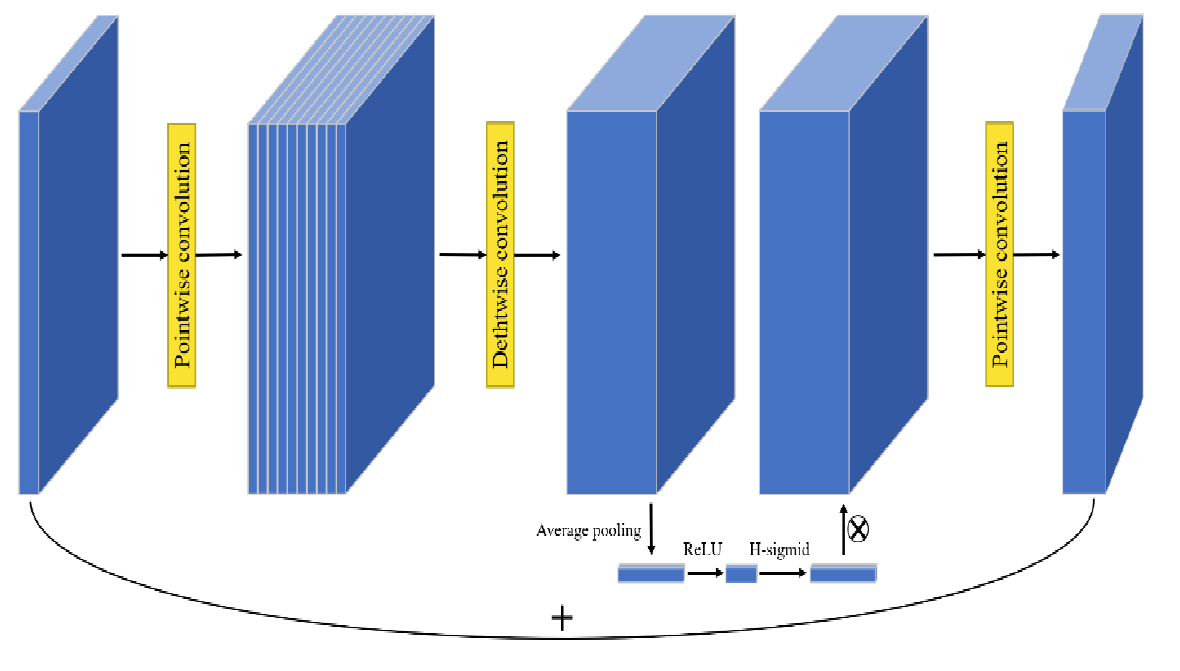
Figure 2. Structure of MobilenetV3.